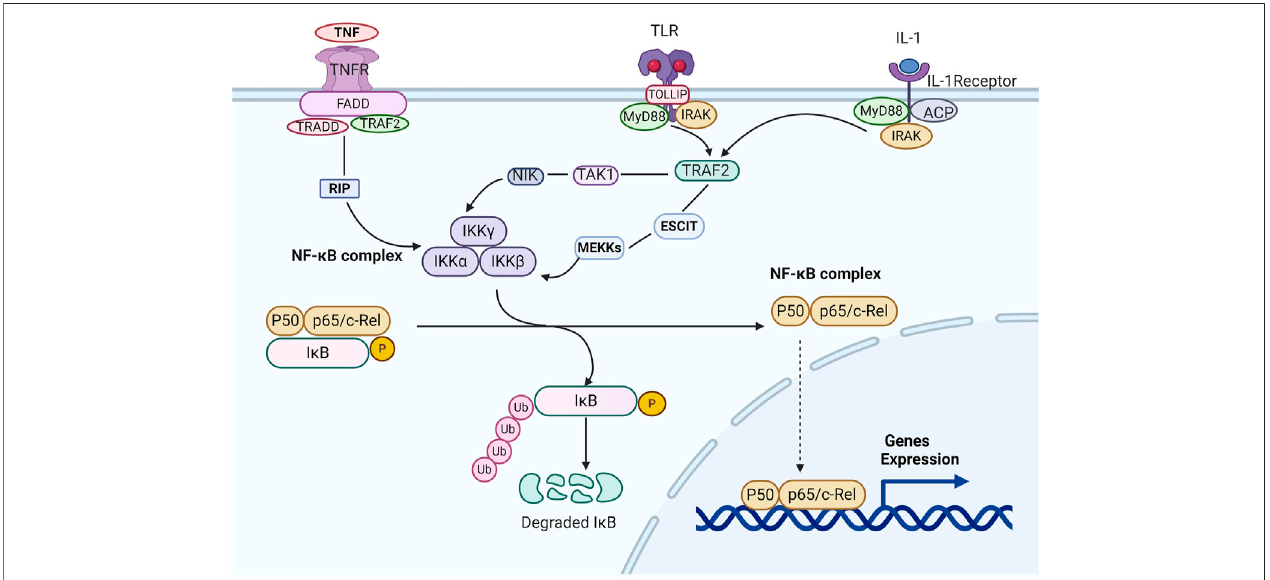
FIGURE 4 | Schematic diagram of the NF- κ B pathway. When the in fl ammatory factors such as tumor necrosis factor A/inteeleukin-1/Toll-like Receptors combine withtherelatedreceptors,theycausethecon fi gurationchangesofthelatterreceptors,likeRIP,NIK,orMEKKs.ThenIKKsareactivated,whichcanphosphorylateI κ B α , and ubiquitinationunderthe action ofthe ubiquitin ligasep-trcp.Theubiquitinligase p-trcp canbe recognized and degradedby26Sproteasome.Therefore, NF- κ Bcan be released from the cytoplasm of NF- κ B/IkB α complex, activate and expose the activate site domain, and rapidly transfer nucleus. Through P50 subunit binding with target genes, the expression of target genes such as TNF- α